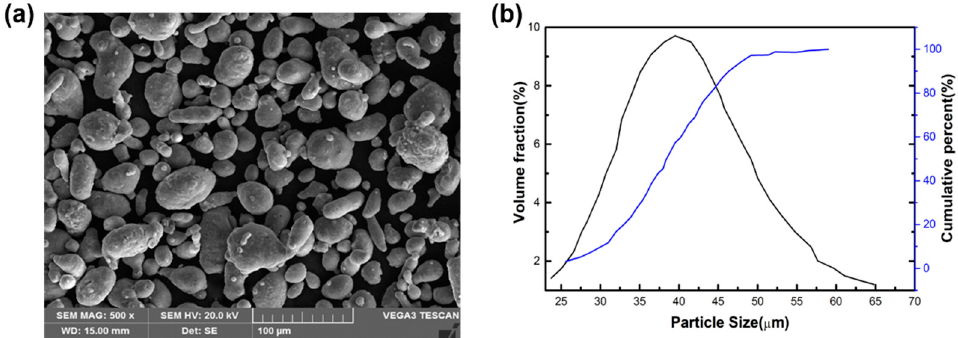
Figure 1. Morphology of AlSi10Mg; ( a ) powder particles, and ( b ) the powder size distribution